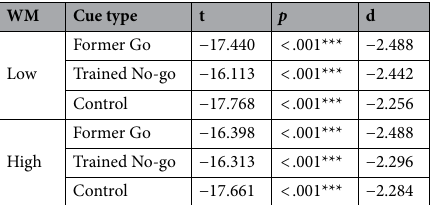
Table 2. One sample t-tests (H 0 = 0) of log SICI data (Fig. 4a) for cue type × working memory load. SICI = ln(single-pulse MEP/paired-pulse MEP). *** p <